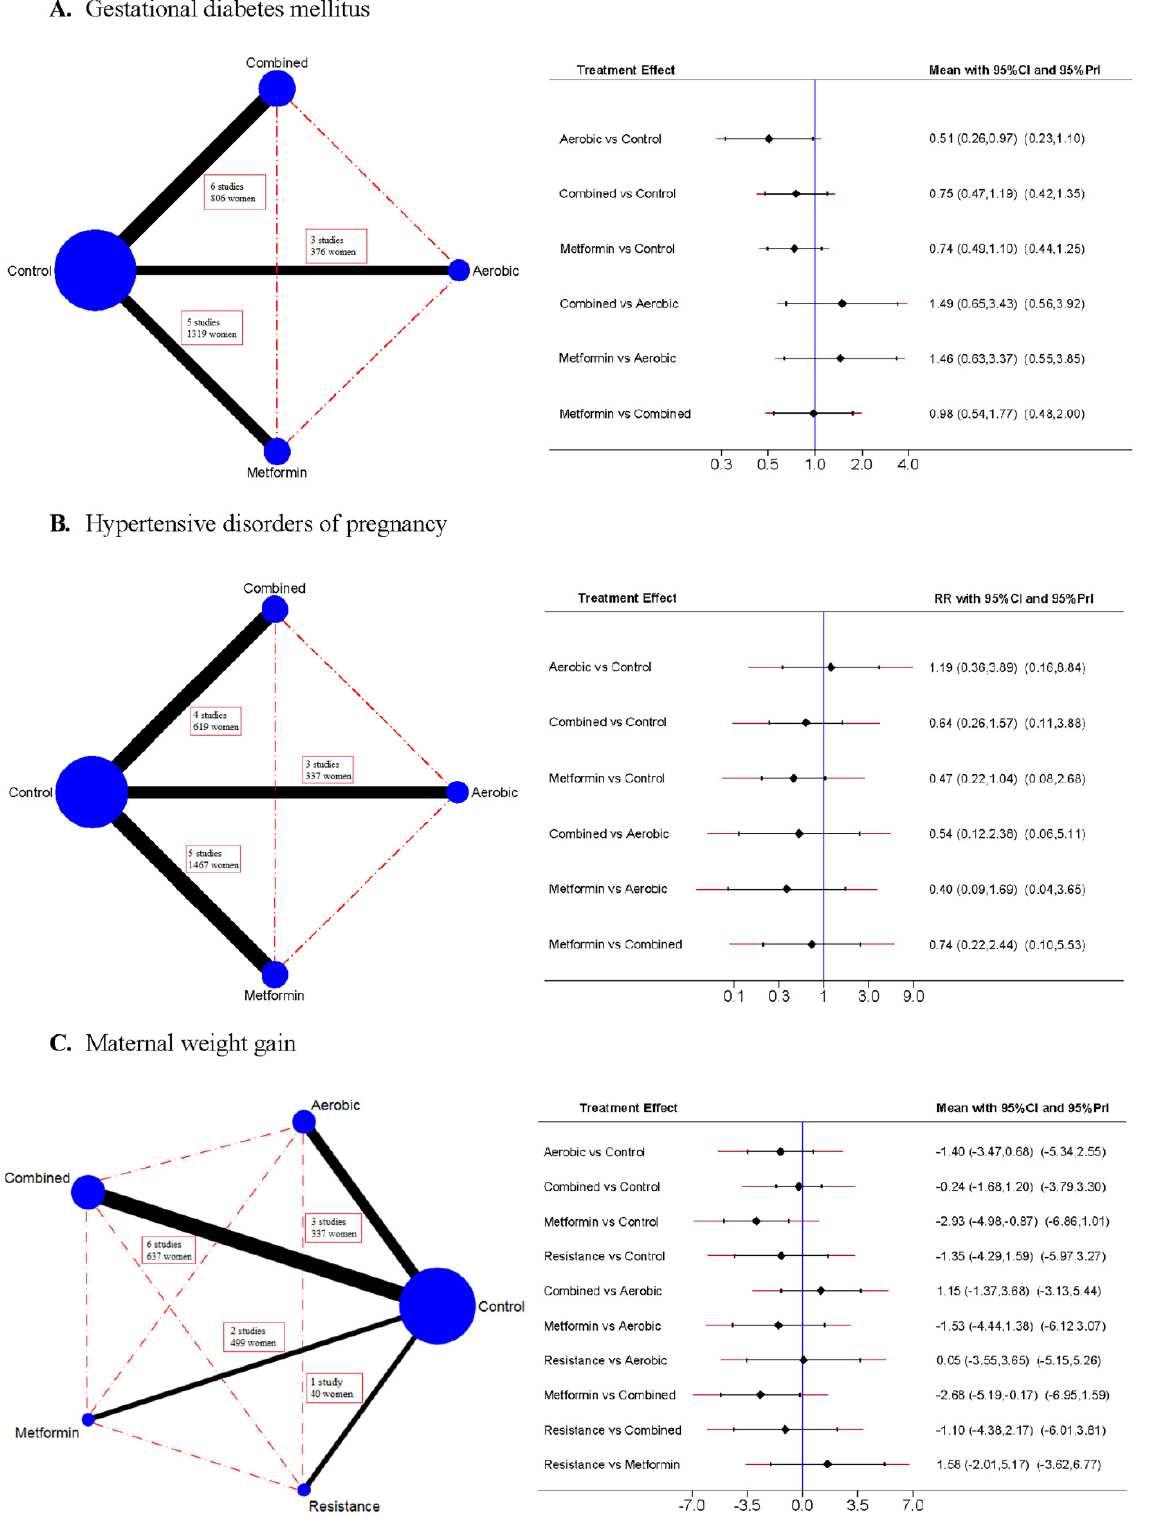
Figure 2. Network mappings and network meta-analyses estimates for gestational diabetes mellitus ( A ), hypertensive disorders of pregnancy ( B ) and maternal weight gain ( C ). The network mappings ( left ) represent the number of participants in each intervention arm, and direct and indirect comparisons. The forest plot/interval plot ( right ) represent the effect size estimates in the network meta-analysis. The risk ratio (RR) was estimated for dichotomous variables, and the main difference (Mean) for continuous variables, with their 95% confidence intervals.